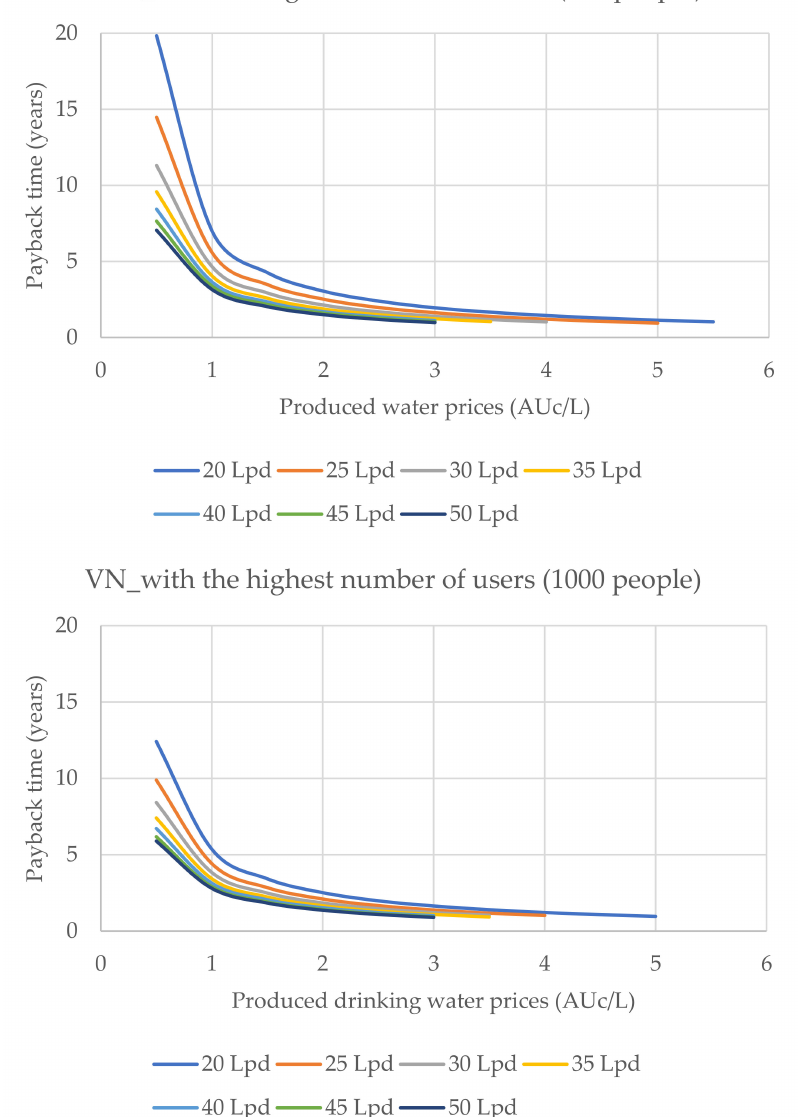
Figure 12. Correlation between produced water prices and payback time for the Australian and Vietnamese RWH systems with respect to the highest number of users and scenarios of drinking water